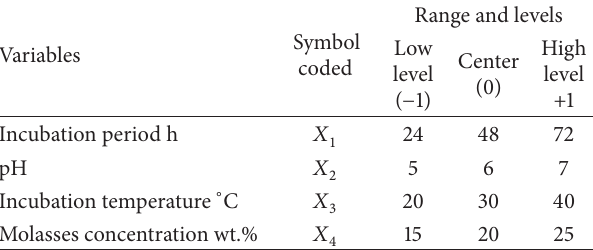
Table 1: Variables and their levels used in the experimental